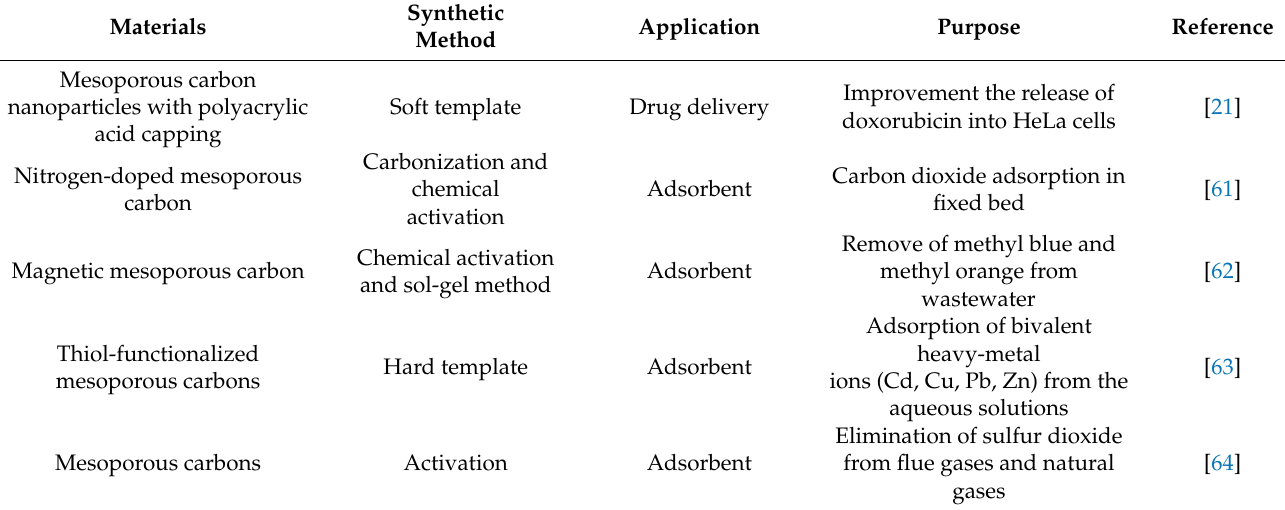
Table 1. Summary of the various applications of mesoporous